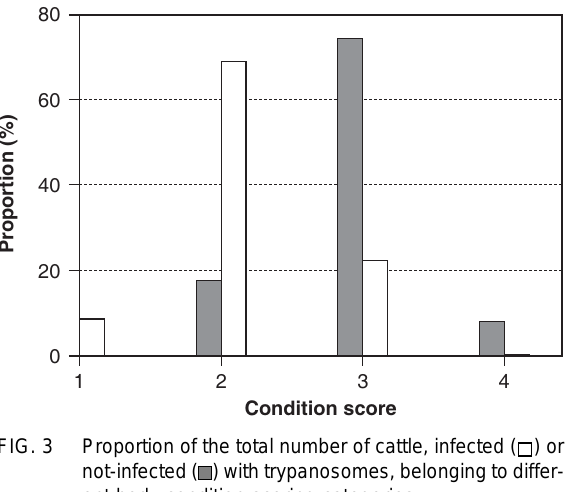
Bovine trypanosomosis in Amhara Region, north-west Ethiopia